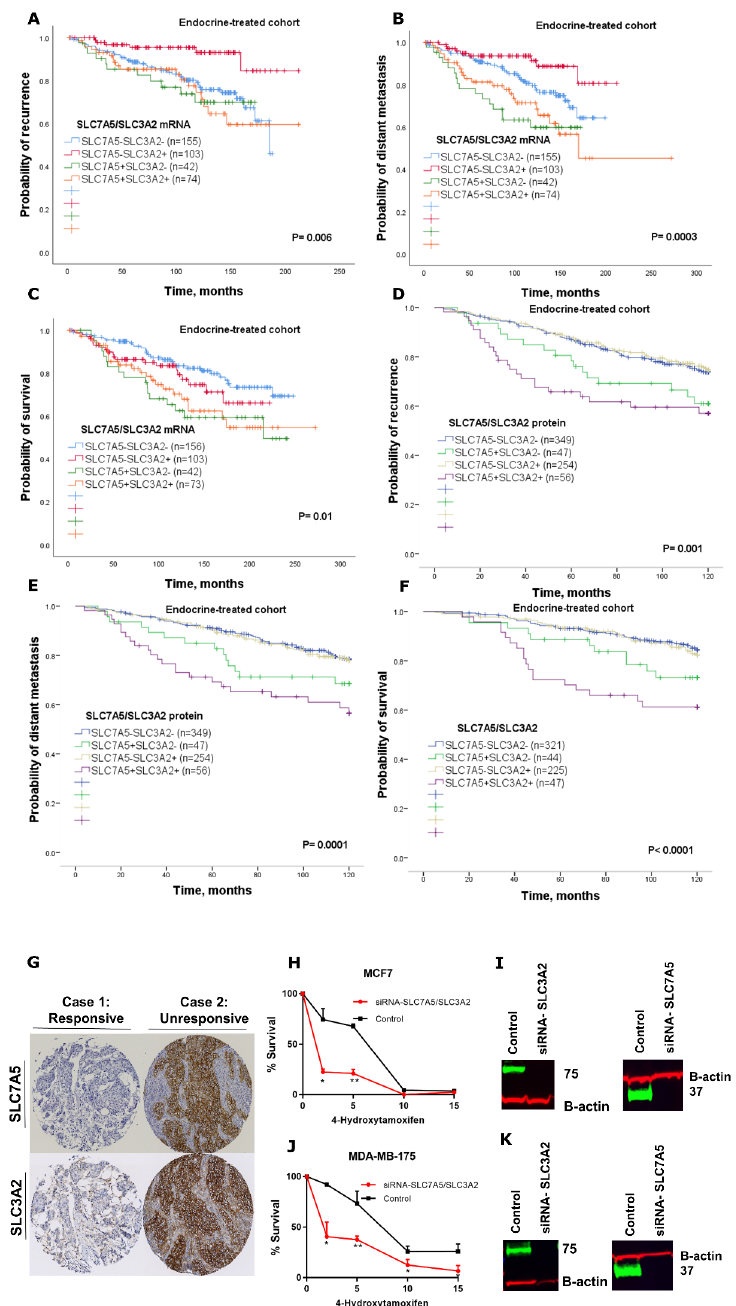
Figure 3. Kaplan–Meier of SLC7A5 / SLC3A2 mRNA co-expression in patients with ER +/ HER2 − breast cancer who received endocrine treatment only using the METABRIC cohort: ( A ) recurrence, ( B ) distant metastasis and ( C ) breast-cancer-specific survival. Kaplan–Meier of SLC7A5 / SLC3A2 protein co-expression in patients with ER +/ HER2 − breast cancer who received endocrine treatment only: ( D ) recurrence, ( E ) distant metastasis and ( F ) breast-cancer-specific survival. ( G ) IHC staining of SLC7A5 and SLC3A2 from two cases of patients who were subject to endocrine therapy alone. Cell viability assay in ( H ) MCF7 and ( J ) MDA-MB-175-VII cells transfected with siRNA control or siRNA targeting SLC7A5 and SLC3A2 (si-SLC7A5 / SLC3A2). Cells were treated with di ff erent concentrations of 4-Hydroxytamoxifen (2, 5, 10 and 15 µ M) for 72 h. Results shown are mean ± SE of at least two independent experiments performed in triplicate. Asterisks denote p -values as follows: * p < 0.05; ** p < 0.005. The e ffi ciency of SLC7A5 and SLC3A2 knockdown in ( I ) MCF7 cells and ( K ) MDA-MB-175-VII was confirmed by Western